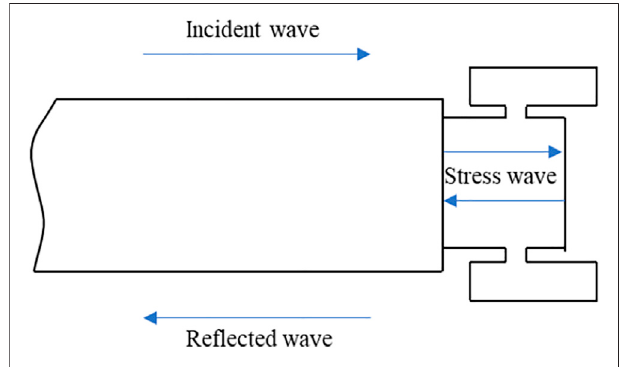
FIGURE 5 | Loading end of